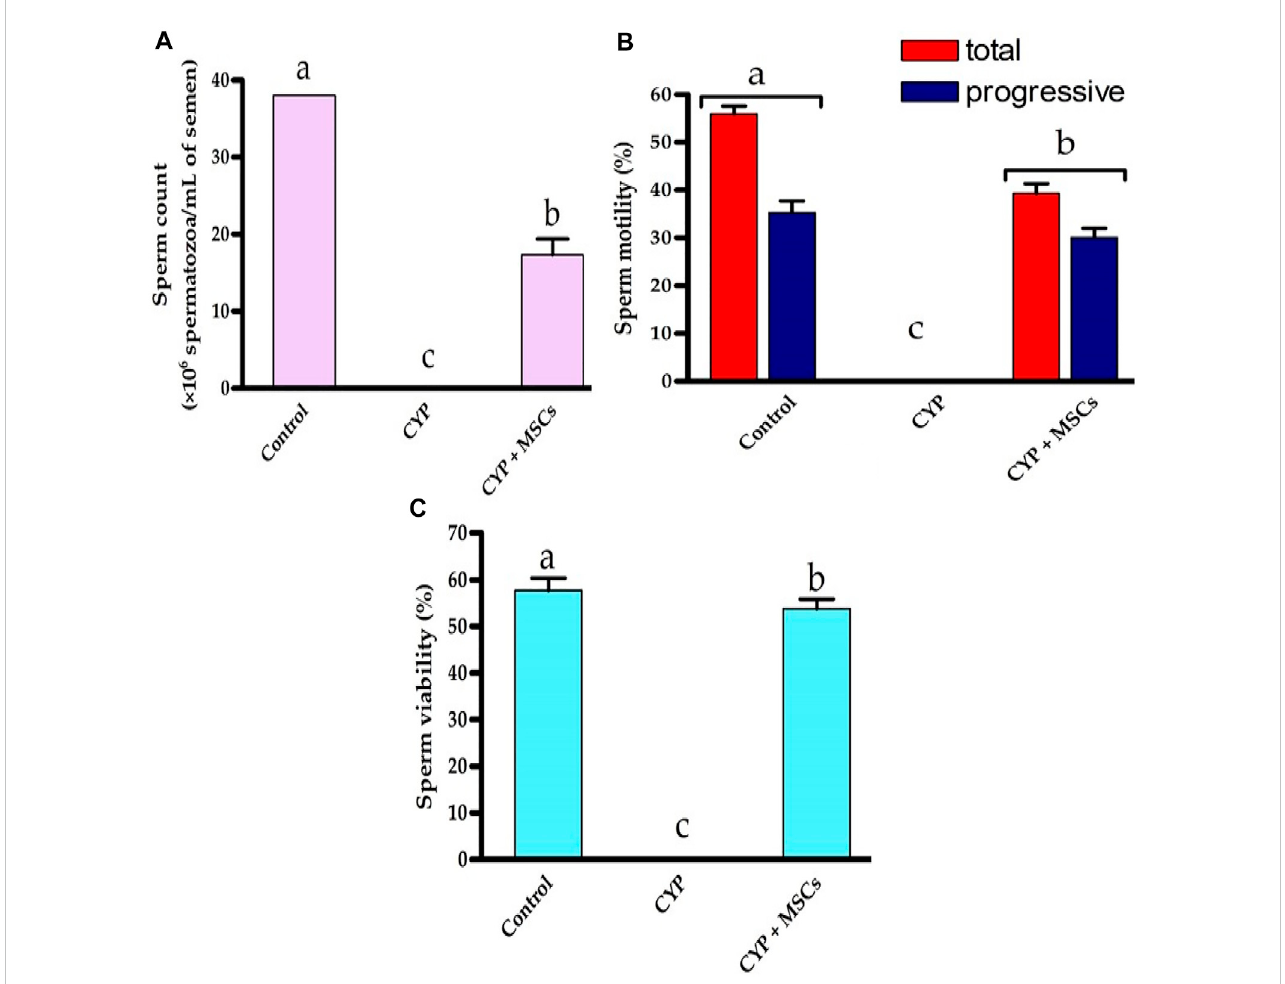
FIGURE 6 In fl uences of CYP with/without MSCs transplantation on semen analysis; (A) Sperm count (×10 6 spermatozoa/mL semen), (B) sperm motility (%), (C) sperm viability (%). Data described as mean ± SD (n = 6). DMRTs show that bars with various letters are substantially different at p =